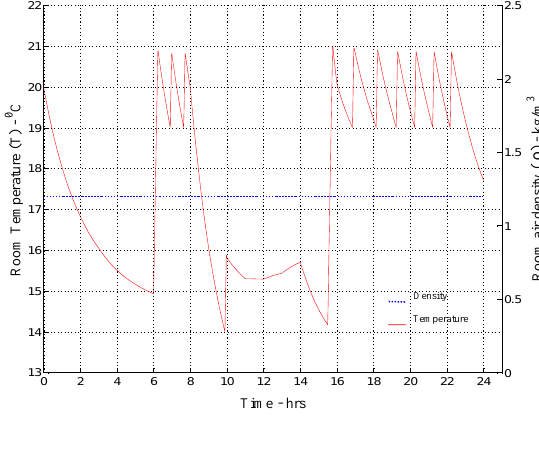
Figure 6: Temperature variation inside the hermet- ically sealed building unit with On/Off control